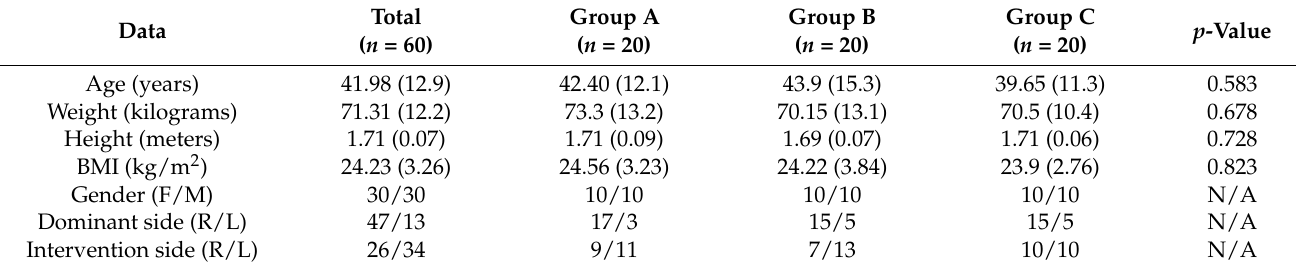
Table 1. Sociodemographic data of the sample.